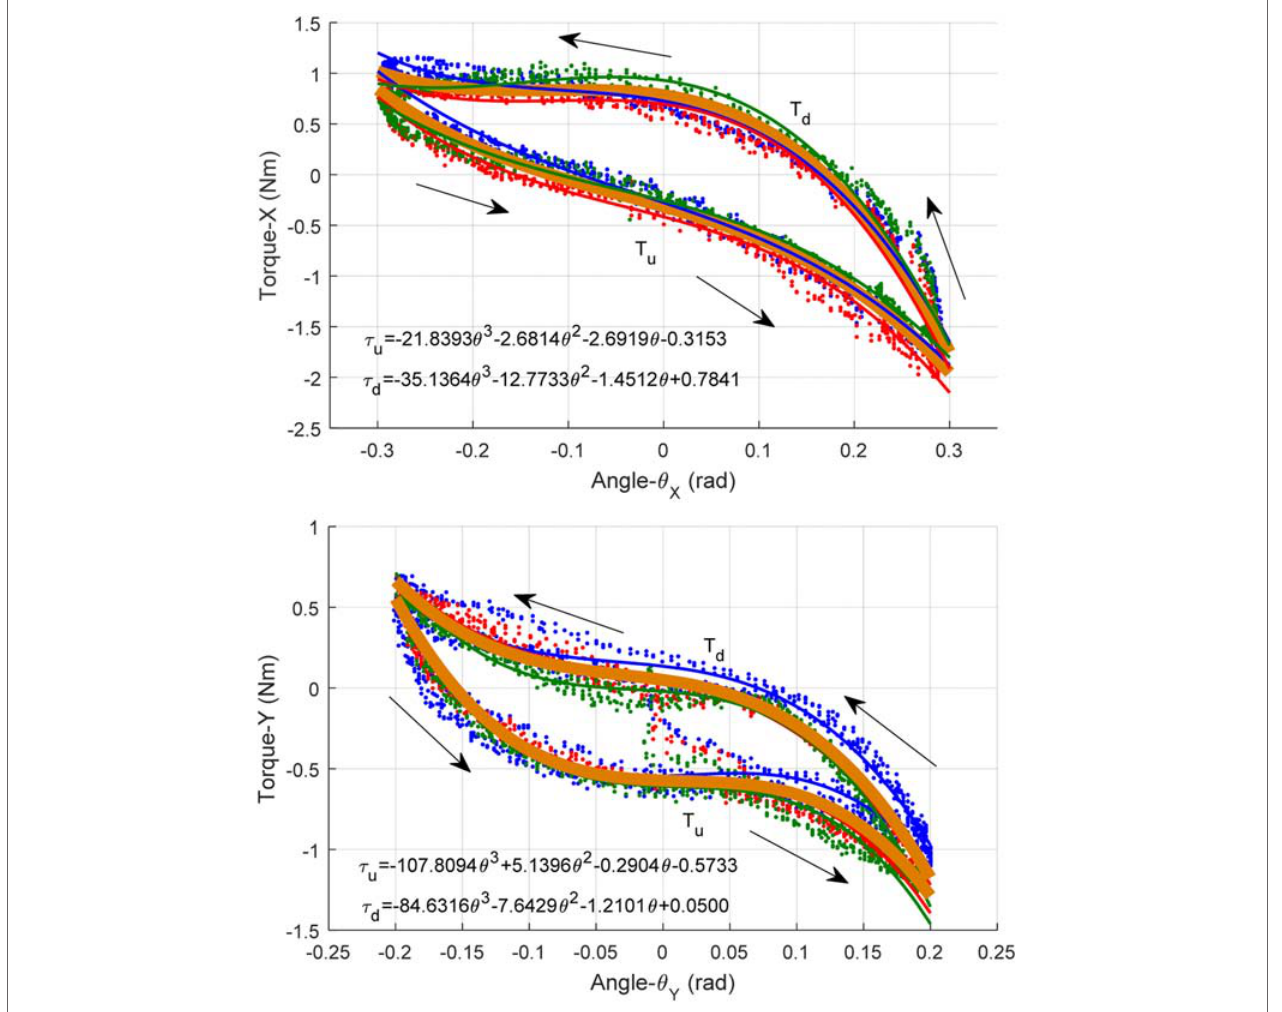
FIGURE 6 | Human ankle passive torque estimation: modeling the torque as a function of ankle joint rotation angle. (Top) Passive ankle toque vs angle about DP and (bottom) about IE.